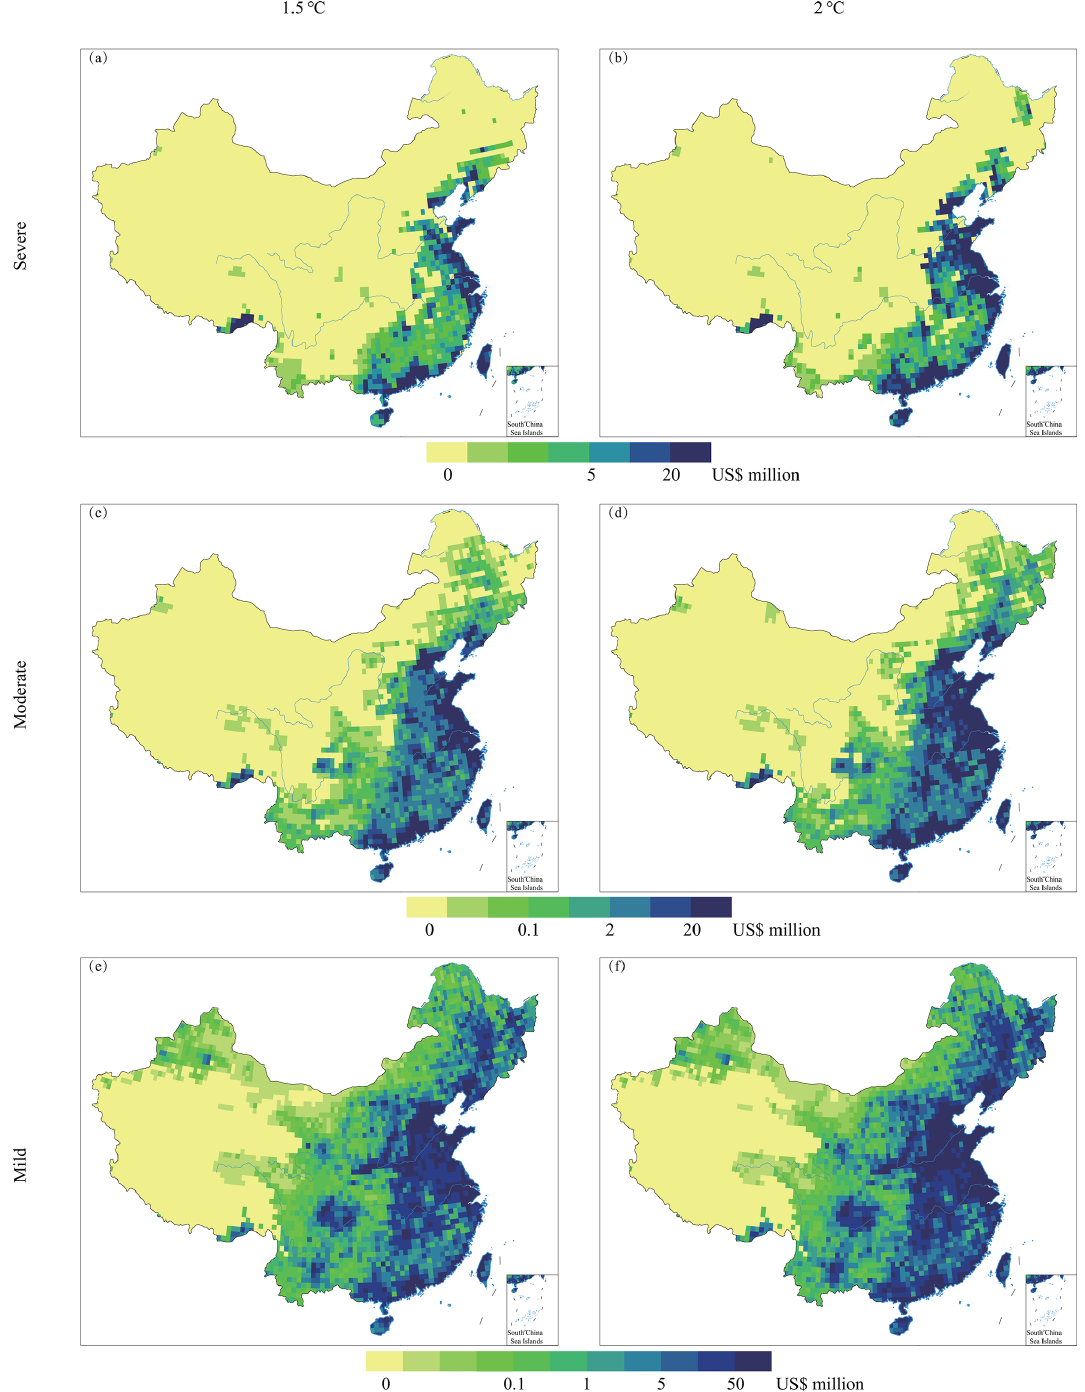
Figure 6. Spatial patterns of the economic risks posed by severe (a–b) , moderate (c–d) and mild (e–f) floods for 1.5 ◦ C (a, c, e) and 2 ◦ C (b, d, f) of global warming under the RCP8.5